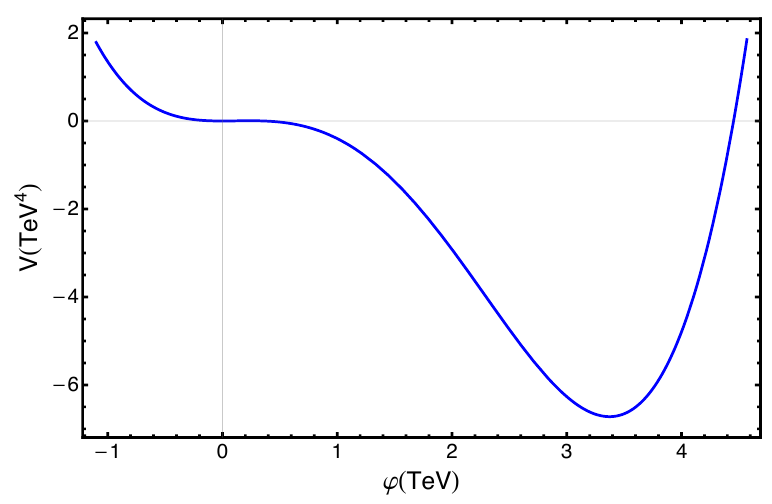
√ = v + ϕ/ 2 , ˜ τ L = 1 . 4 ϕ √ , ˜ τ R = 1 . 5 ϕ √ and for u 2 2